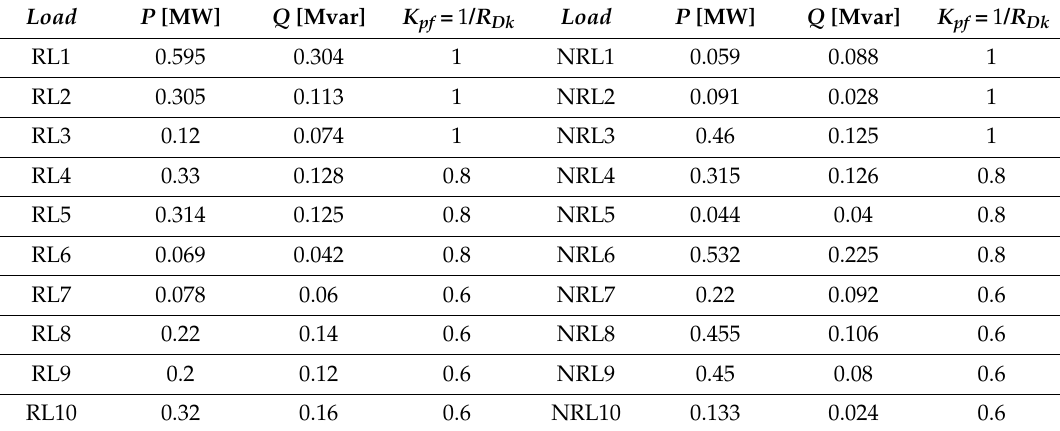
Table 1. Characteristics of the individual demands for the Test Network.